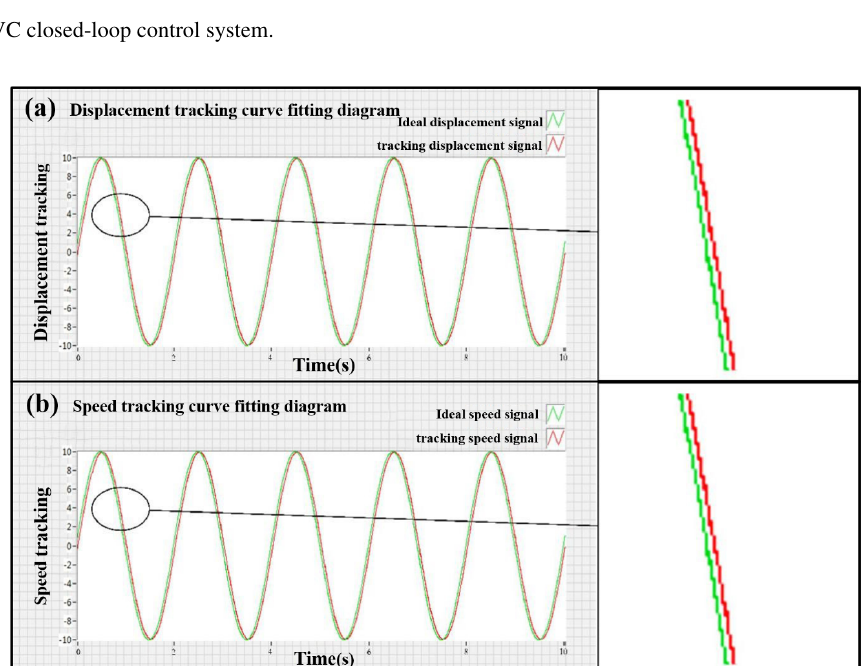
Figure 7. Tracking curve-fitting diagram. (a) Displacement tracking curve-fitting diagram. (b) Speed tracking curve-fitting